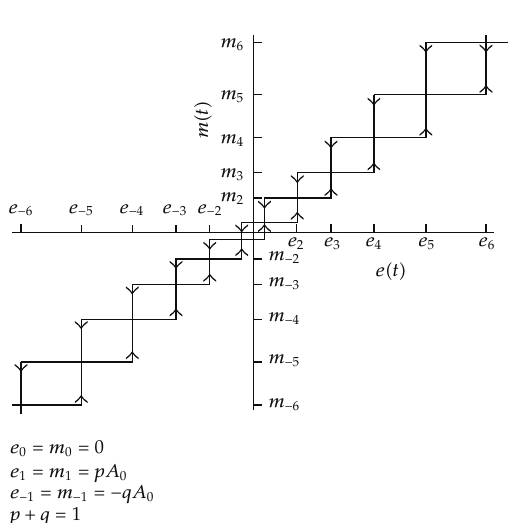
Figure 1: Multirelay with hysteresis nonlinear characteristics of the sampling criterion.